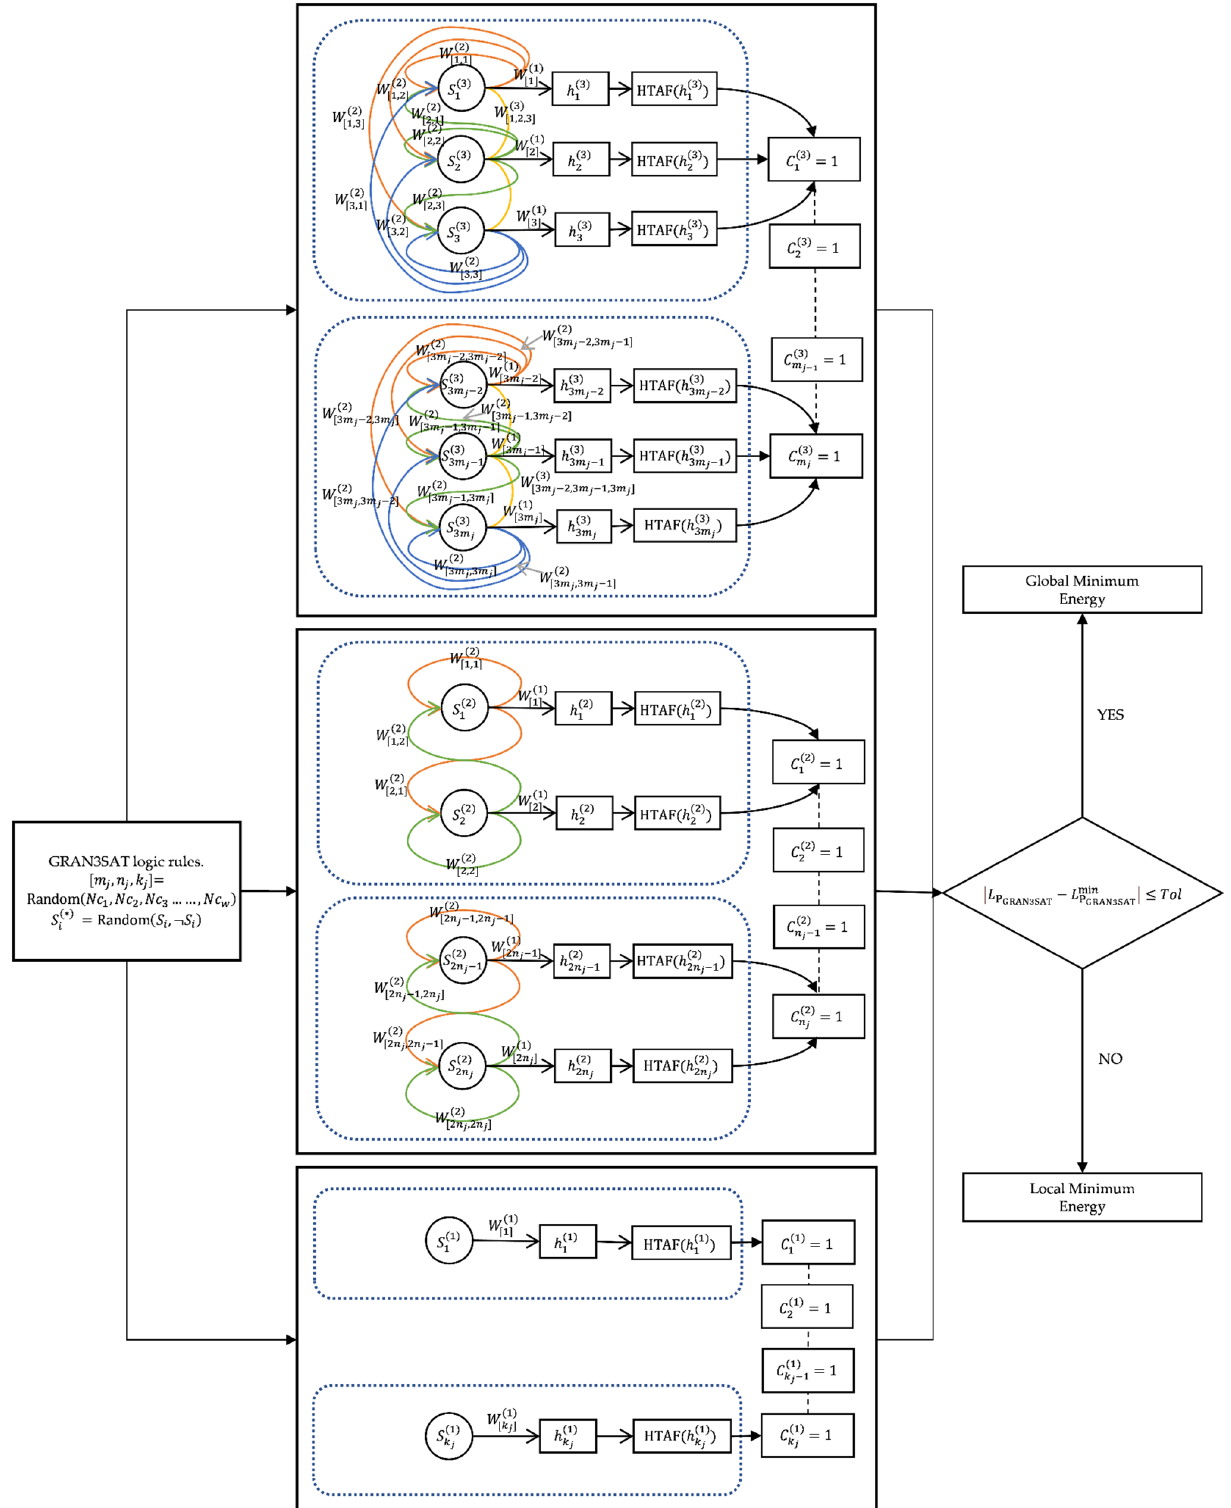
Figure 1. Schematic diagram for GRAN3SAT.